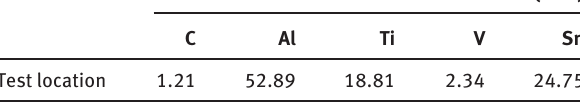
The wear volume loss was measured after 40 min. The